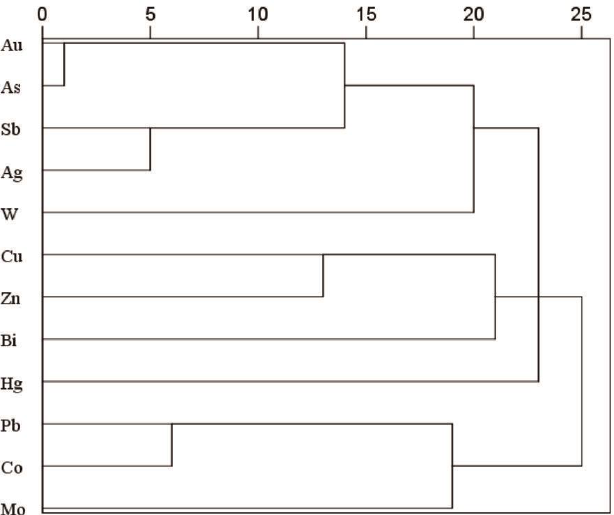
Figure 10. Hierarchical dendrogram of cluster analysis in Zaozigou gold deposit.